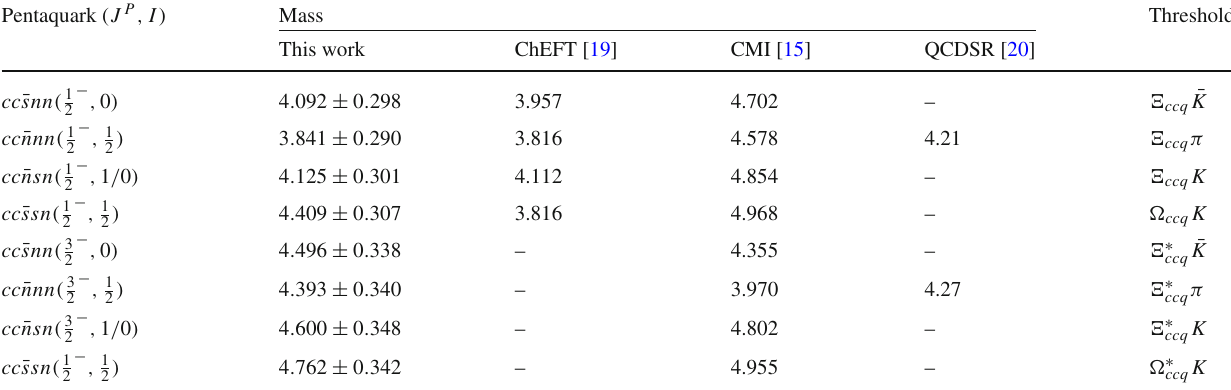
− , 3 − , in the unit of GeV. n represent the light quark u , d . I 2 2